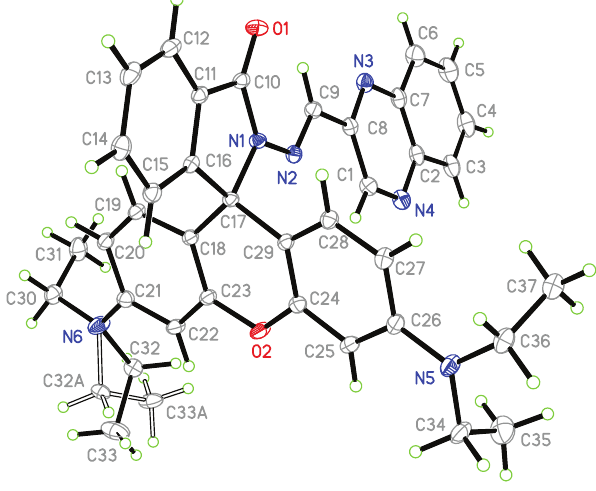
Table 1: Data collection and